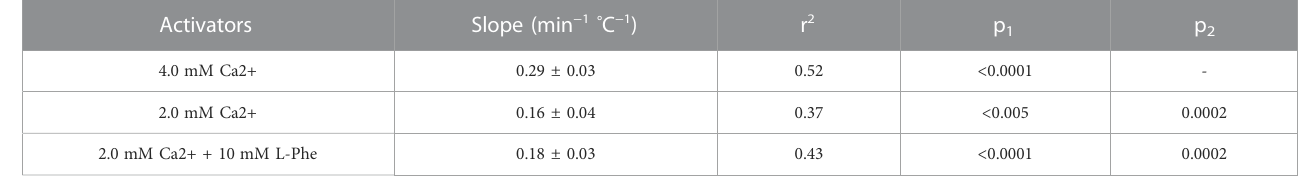
TABLE 1 Linear relationships between temperature and Ca 2+ i frequency in HEK-CaSR cells exposed to Ca 2+ o in the absence or presence of L-Phe Temperature: Ca 2+ i frequencydatawereobtainedinHEK-CaSRcellsexposedto1)near-maximalCa 2+ frequency relationships are presented ±SE, together with the associated r 2 values. p 1 values represent the probabilities that the calculated slopes were the same as zero. p 2 valuesrepresenttheprobabilitiesthatthecalculatedslopesfor2 mMCa 2+ o intheabsenceorpresenceof10 mM L-Phewerethesameasthoseobservedincells exposed to 4.0 mM Ca 2+ o . In all cases, the p -values demonstrate that the null hypotheses (no difference) were